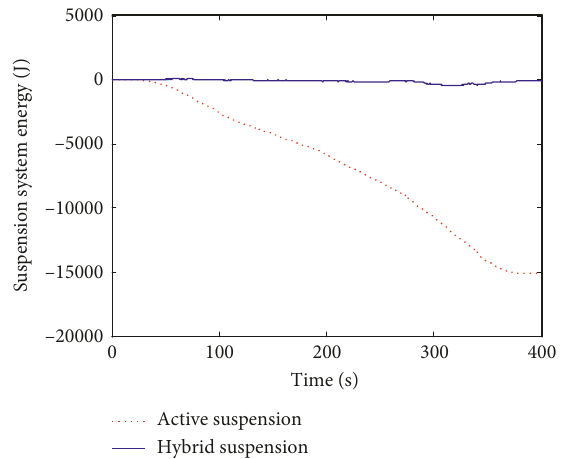
Figure 22: The system energy of the hybrid suspension in suburban circulation units.